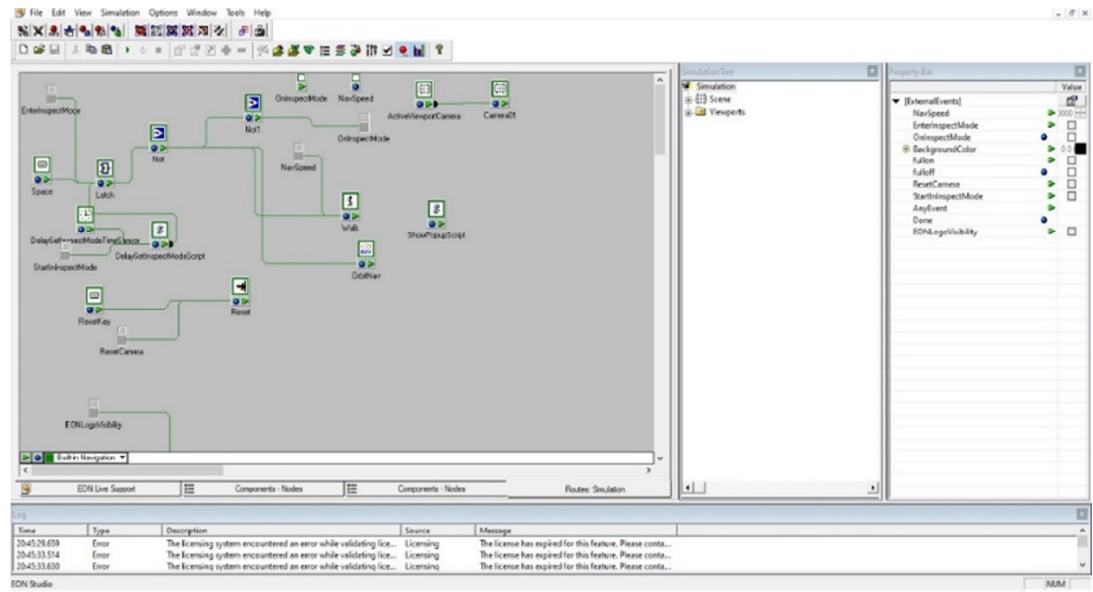
Fig. 8. Nodes interaction.